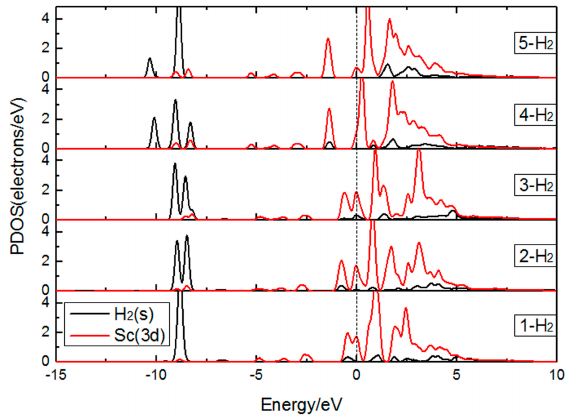
Figure 5. PDOS of Sc-decorated PG with one to five H 2 molecules adsorbed.